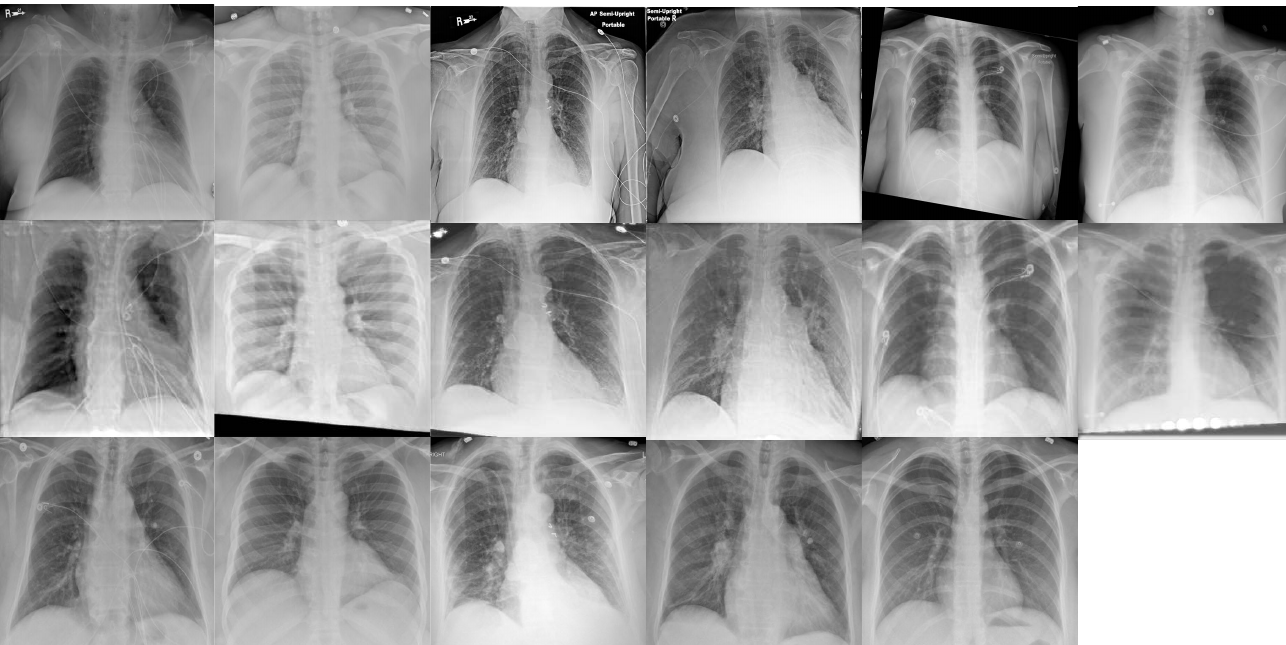
Figure 11. Examples of our alignment and enhancement results. From top to bottom—first row: portable CXR; second row: enhanced CXR from aligned portable CXR; third row: conventional CXR(d). Each column presents one subject. The last column is a COVID-19 case and there is no conventional CXR for this